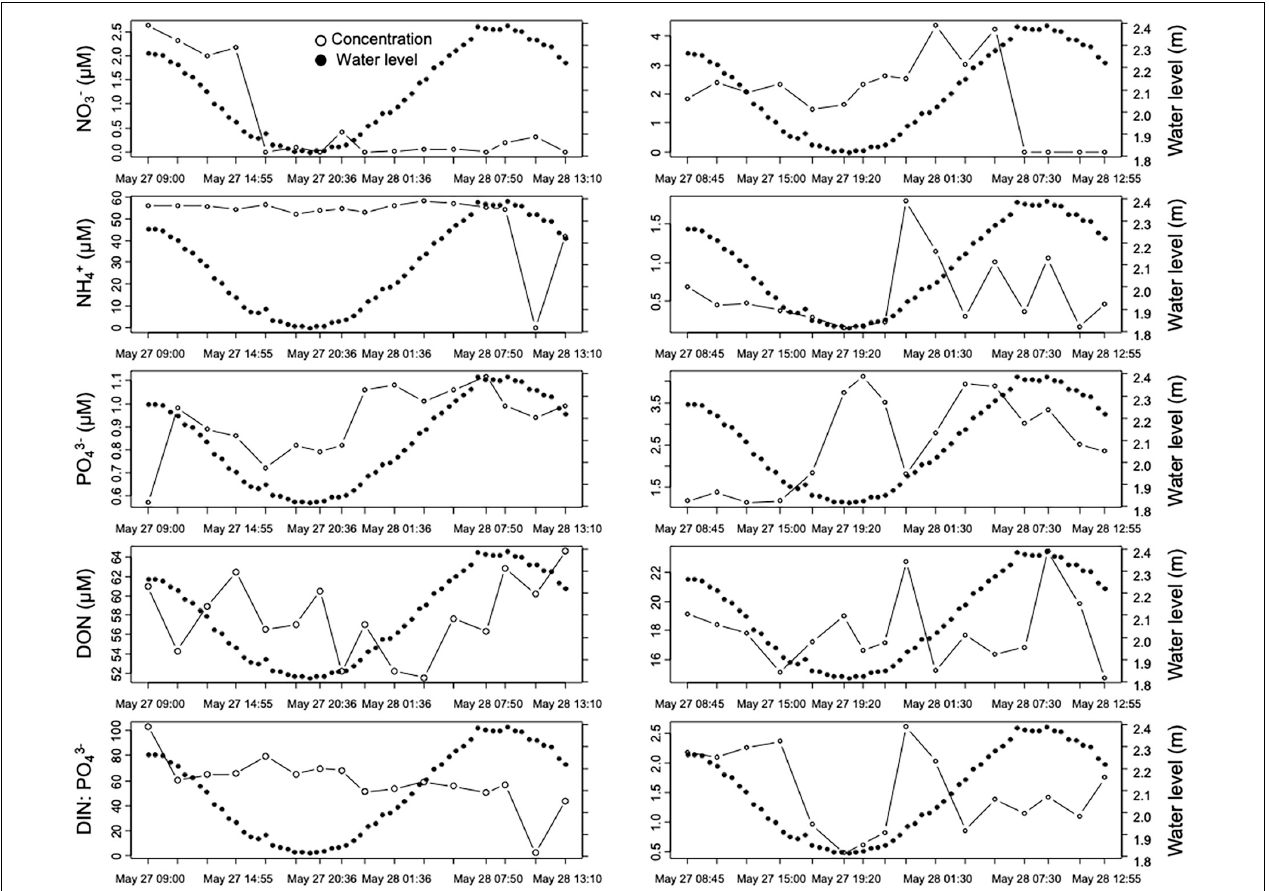
FIGURE 5 | Time series measurement of nutrient in the groundwater (left) and coastal water (right) plotted against tidal cycle in DISL